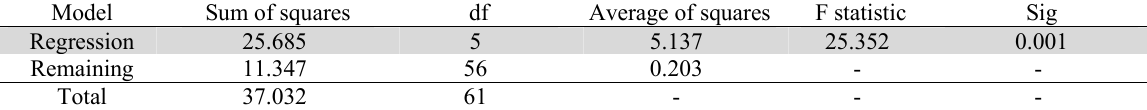
Investigation into the linear relationship between predictor and criterion variables Model Sum of squares df Average of squares Regression